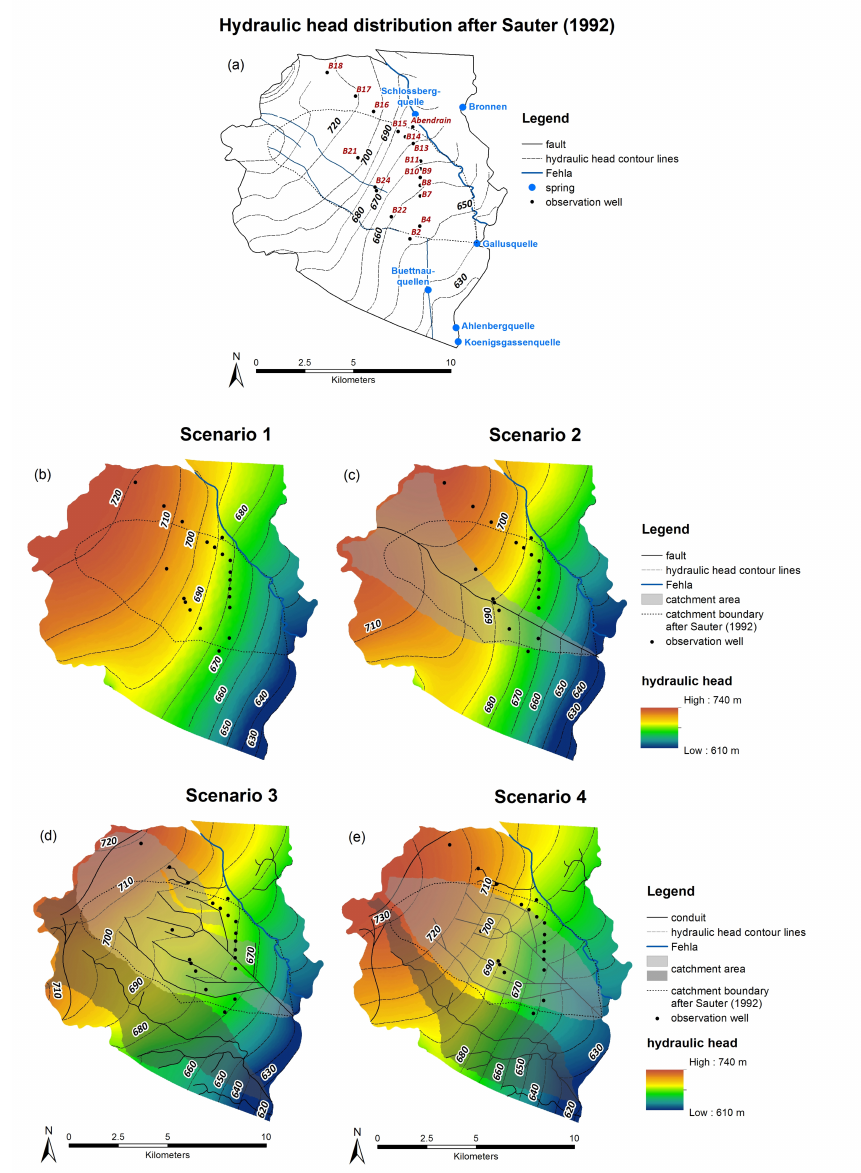
Fig. 5. Hydraulic head distributions and simulated catchment areas. (a) after Sauter (1992), derived from borehole measurements. (b) after the homogeneous simulation. (c) after the simulation with fracture flow along the northern fault of the Hohenzollerngraben. (d) after the simulation with a 1-D conduit network with constant radius. (e) after the simulation with a 1-D conduit network with increasing